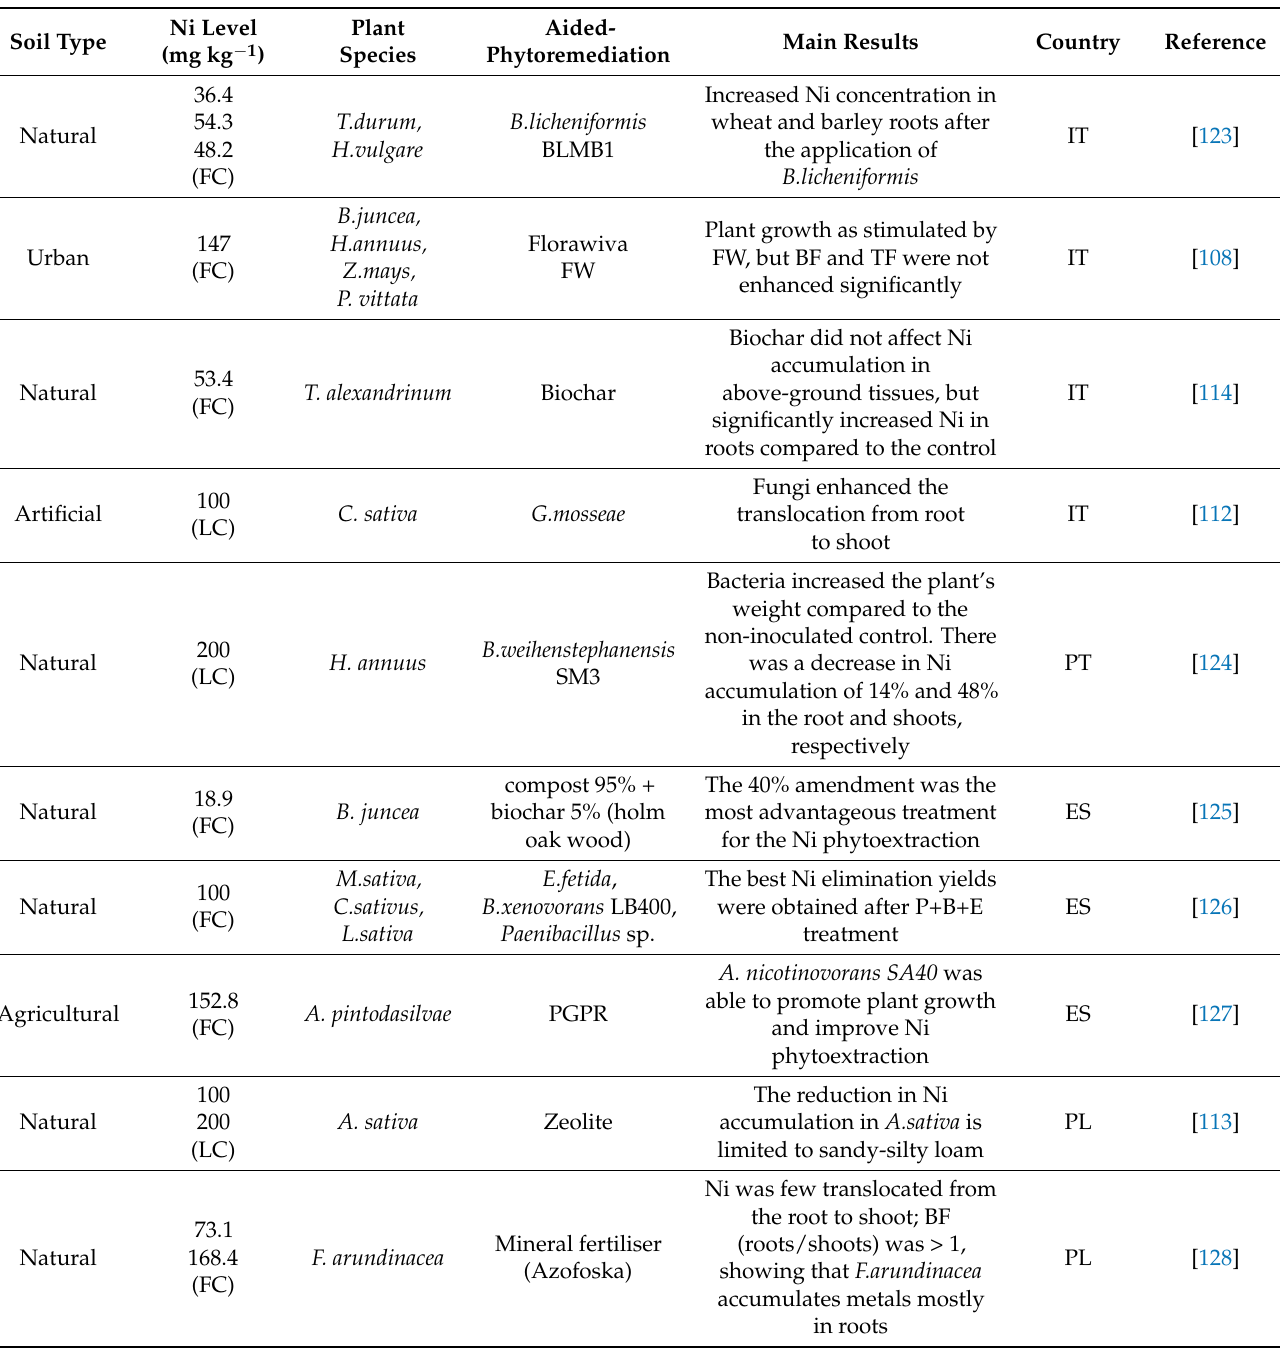
Table 1. European aided phytoremediation experiments with low/moderate Ni contamination. (FC: field contamination; LC: laboratory